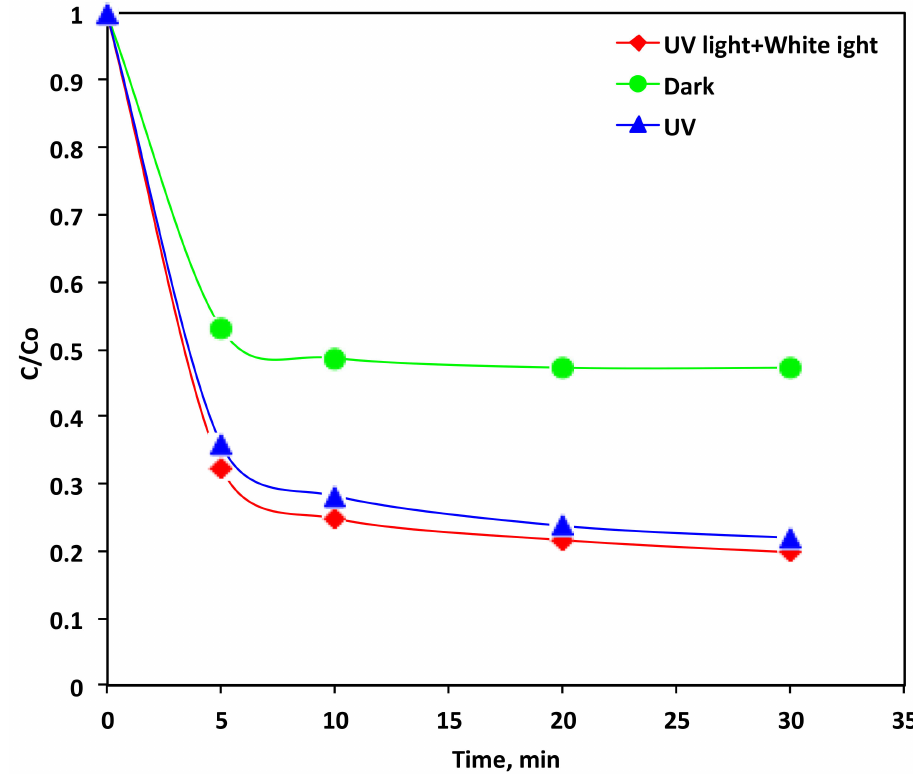
Figure 9. Effect of the different light sources on the Reactive Blue 4 oxidation by the PANI-MWCNTs system (Experimental conditions: Reactive Blue 4 = 10 ppm; PANI-MWCNTs: P-5 = 10